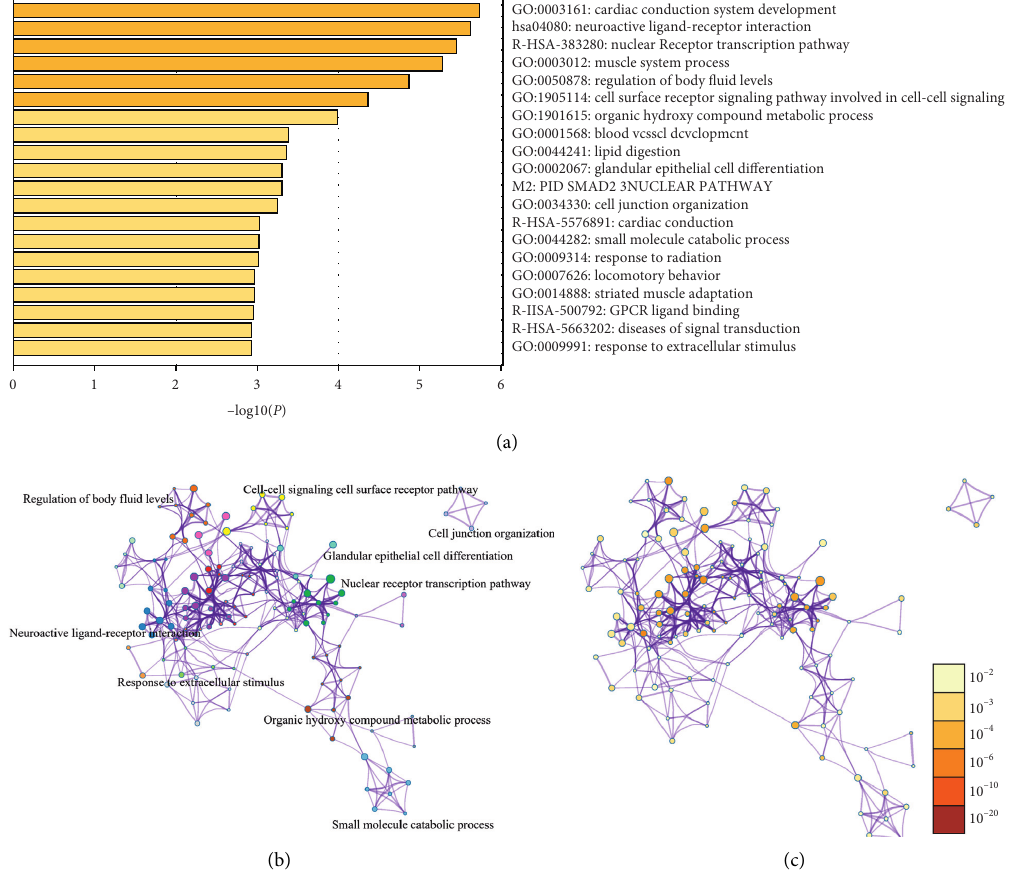
Figure 3: The enrichment analysis of DEGs by Metascape. (a) Bar graph of enriched terms across DEGs, colored by P values. (b) Network of enriched terms, colored by cluster. (c) Network of enriched terms, colored by significant P